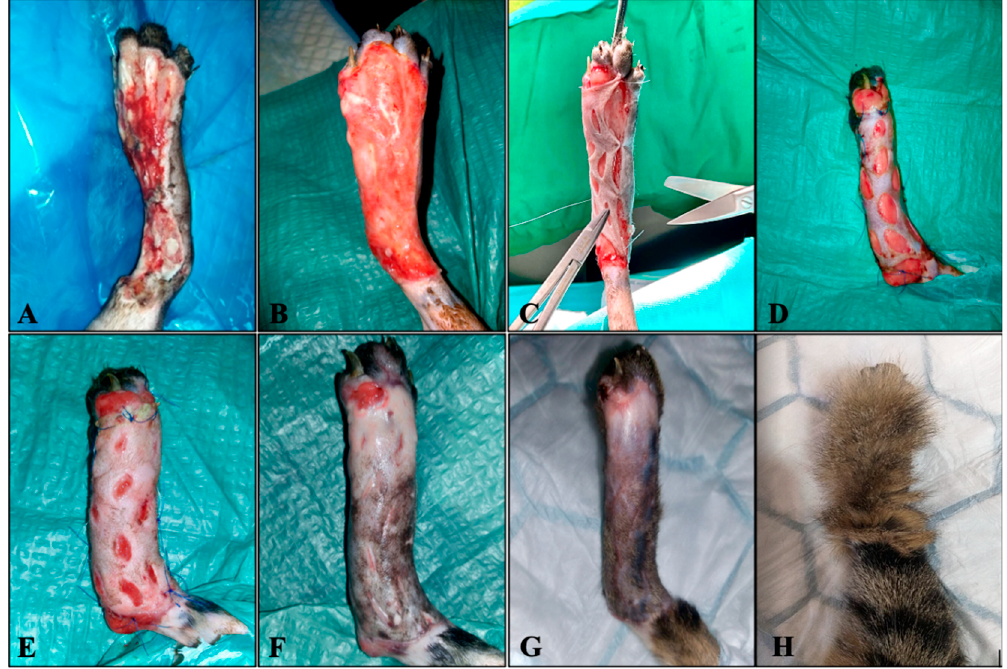
Figure 1. Clinical progression of the wound. ( A )—Wound appearance at the time of the patient’s appointment at the clinic, areas with necrosis and devitalized tissue, with exposure of the tendons and bones. ( B )—Wound on day 17 after 8 sessions of ozone therapy with healthy granulation tissue and with the edges of the wound undergoing epithelization. ( C )—Application of the skin graft. ( D )—3 days postoperatively. ( E )—6 days postoperatively. ( F )—9 days postoperatively. ( G )—12 days postoperatively. ( H )—60 days postoperatively (note the longer length and color changes of the new hair).